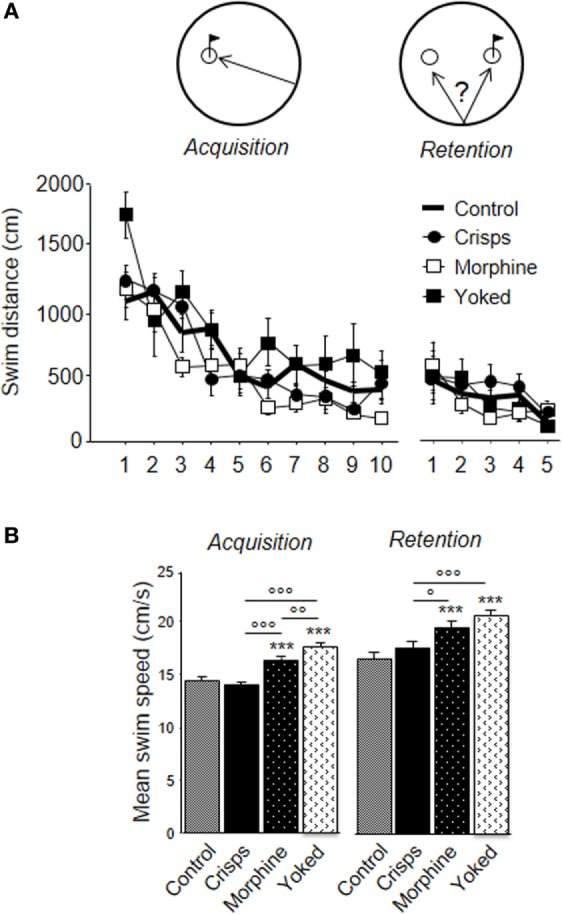
Learning parameters in the water-maze competition task. (A) All animals learnt to retrieve more precisely the hidden platform during the acquisition phase. During the retention phase, animals reached a plateau and did not further decrease their latency to escape. (B) Analysis of swim speed revealed that mice previously injected with morphine swam faster during both phase of the water-maze task than Crisps (°p < 0.05, °°p < 0.01, °°°p < 0.001) and artificial cerebrospinal fluid group (***p < 0.001).